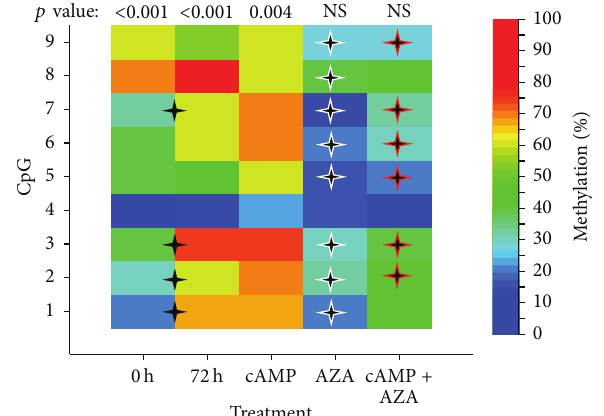
Figure 4: Methylation of individual CpG dinucleotides at 0h and 72 h of culture (0h and 72 h, resp.), after 72 h with 8-Br-cAMP (cAMP) and after 72 h with 5-AZA-dC (AZA), and the combination ofthetwo(cAMP+AZA).Treatmentsaredenotedonthehorizontal axis and CpG numbers (shown in Figure 3) are indicated on the vertical axis. The heatmap shows % methylation according to the scale on the right. Three independent experiments with ten clones (randomly selected individual gene copies) sequenced at each time point were combined to calculate % methylation. The statistical significance of methylation frequency differences among the CpG sites at each treatment condition is shown on the top (Fisher’s exact test). The black crosses indicate significantly different methylation of CpGs 1, 2, 3, and 7 between 0h and 72 h; crosses with white lining in the AZA fields denote significant CpG-site-specific differences compared to 72 h, and crosses with red lining in the cAMP + AZA fields denote significant differences of CpG site methylations as opposed to cAMP treatment alone ( 𝑝 < 0.05 , Fisher’s exact test).